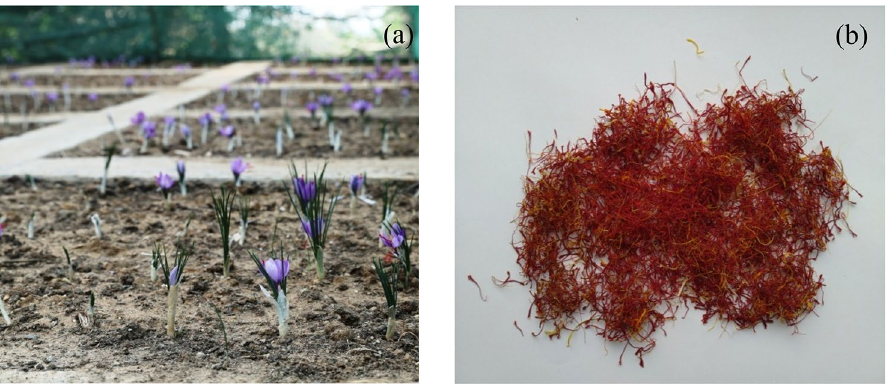
Figure 2. ( a ) Flowering in saffron, and ( b ) dried saffron